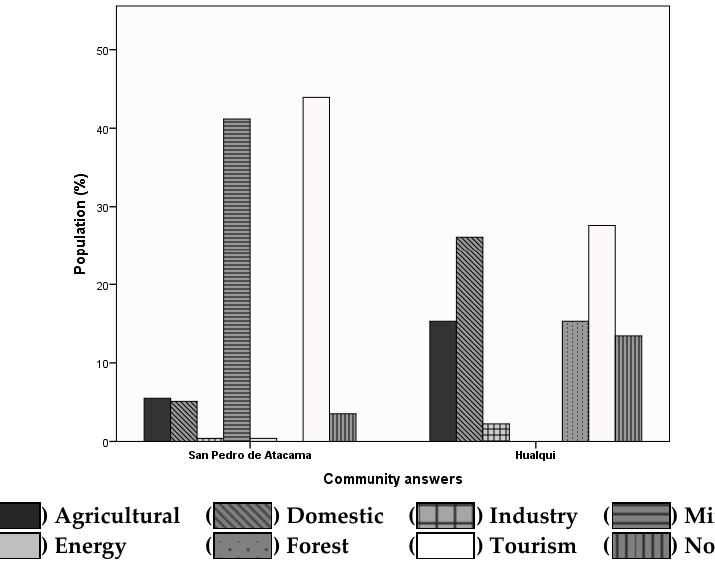
Figure 3. Main users of water in San Pedro de Atacama and Hualqui.